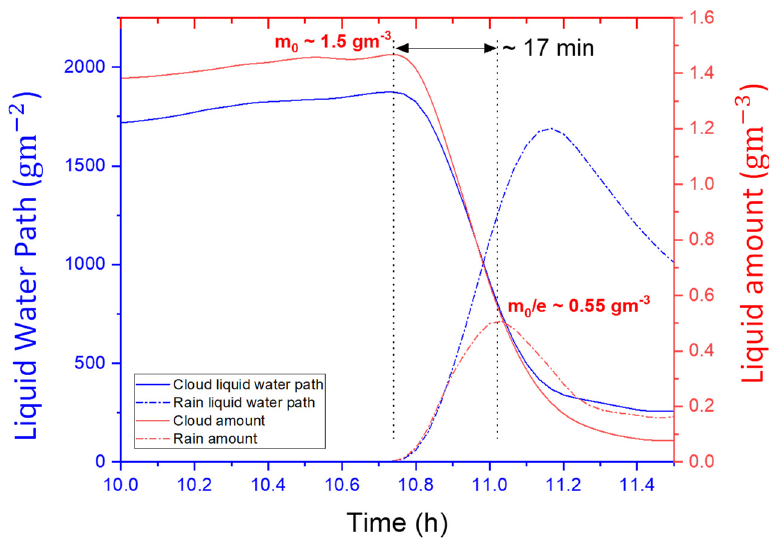
Figure 3. Temporal evolution of cloud and rainwater amounts and paths. Note that the rain mass increases with a sharp dip in cloud mass amounts, indicating efficient auto-conversion after 10.7 h (1608 IST). Note that the e-folding time was estimated to be 16.8 min . The onset time of precipitation is generally a time measure for the initial cloud mass 230 ( m (cid:2868) ) to decrease to 1/ e of the starting amount (Ghosh and Jonas [21]). One can notice from 231